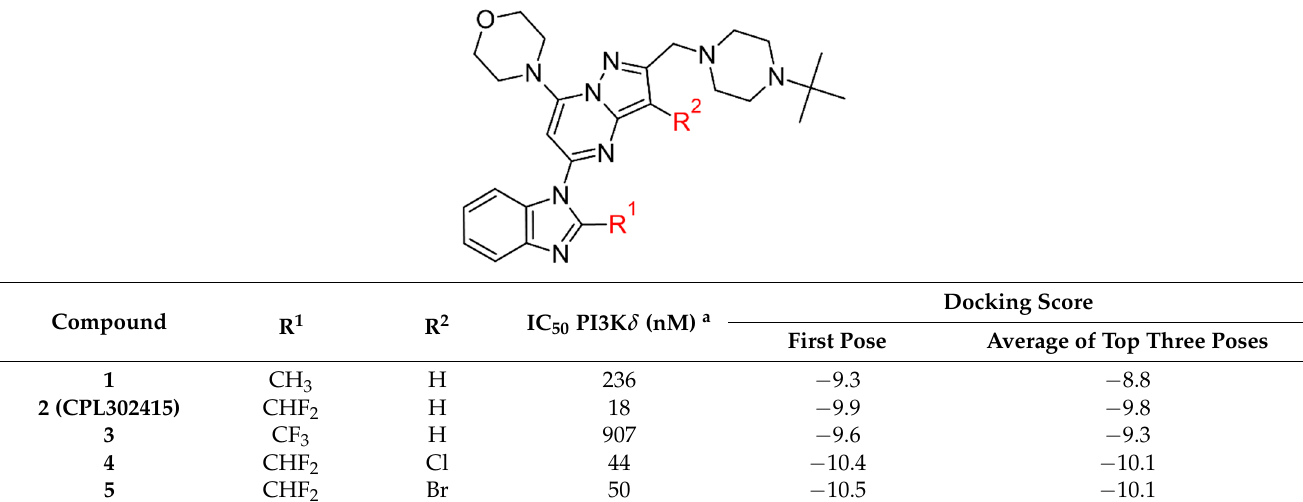
Table 1. Influence of the fluorine atom(s) on PI3K δ inhibition and the respective docking scores for each derivative.